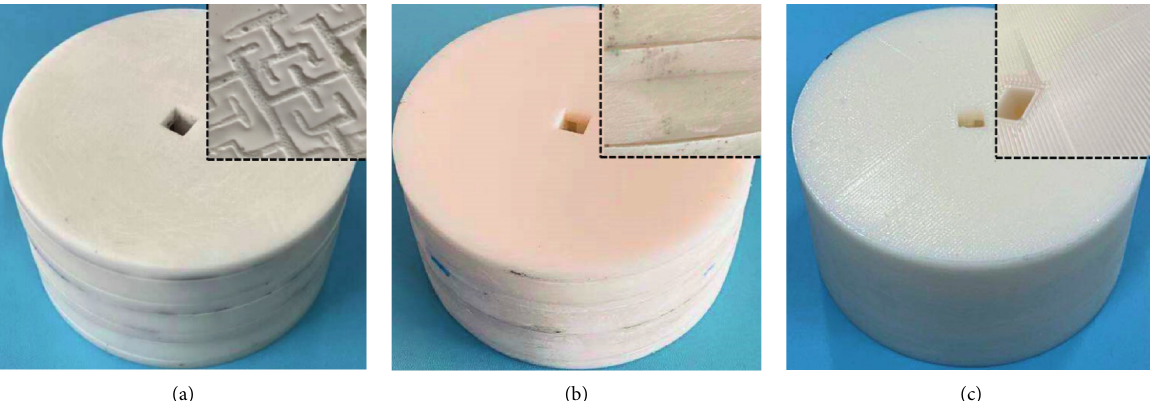
Figure 14: Overall model and local structure of metamaterials. (a) Silicone rubber glue model. (b) Cyanoacrylate glue model. (c) Overall model.